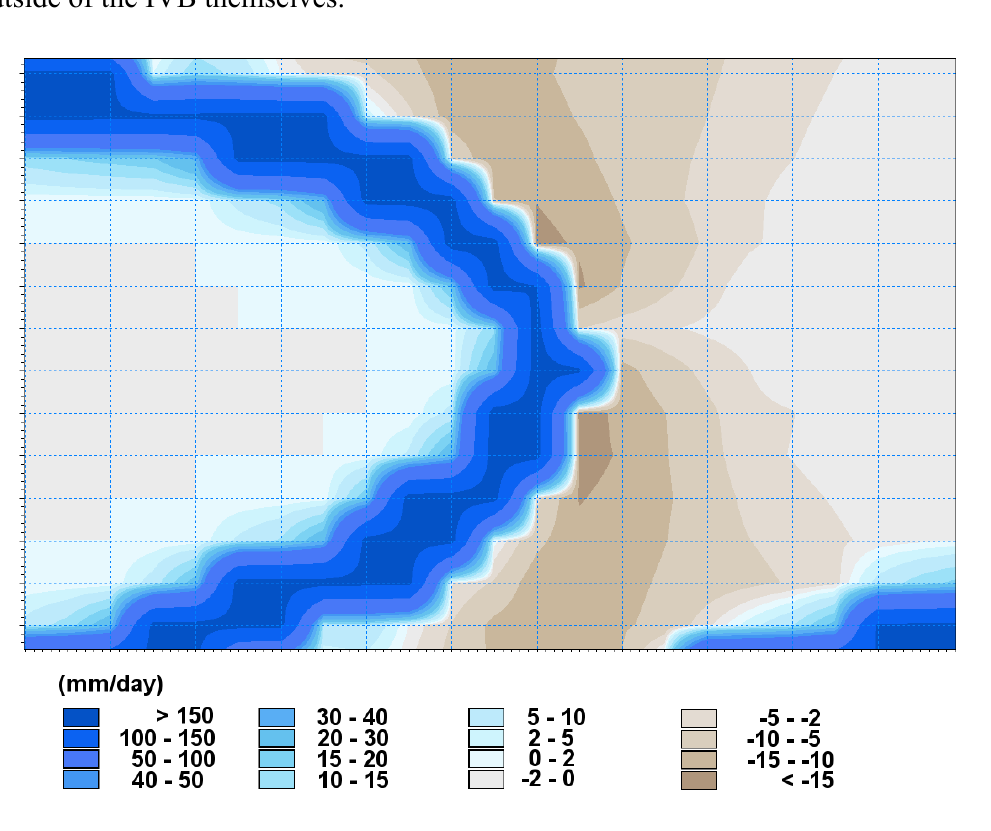
Figure 6. Raster model showing change in mean infiltration (mm/day) under IVB (NB: the location is the same as Figure